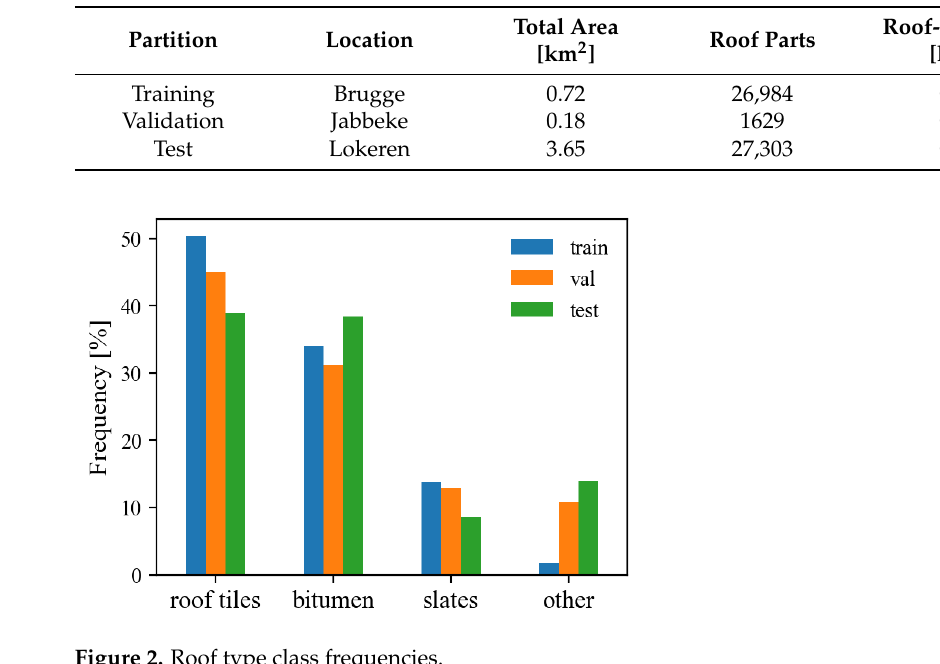
Figure 2. Roof type class frequencies.